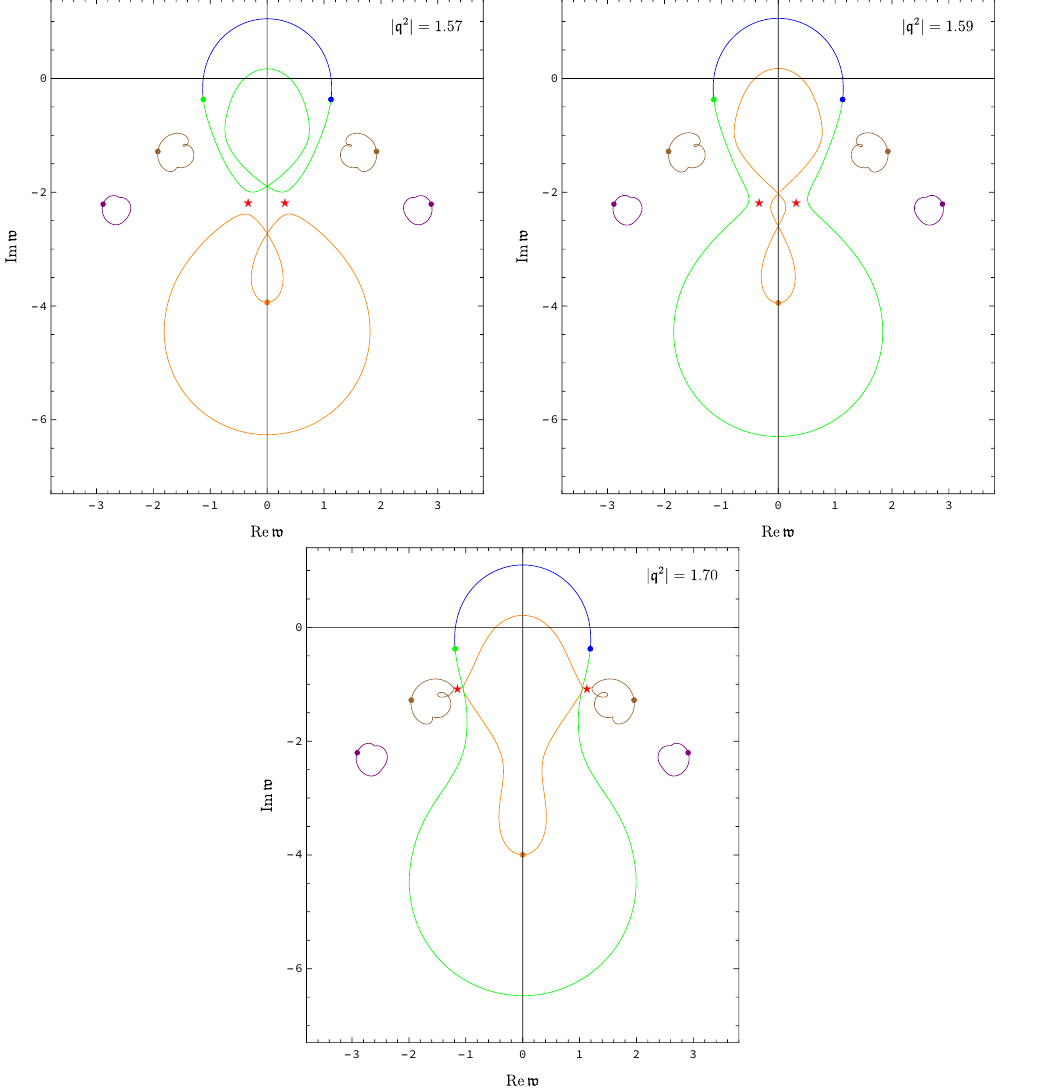
Figure 15 . Quasinormal spectrum in the sound channel of Gauss-Bonnet theory, computed non- perturbatively in λ , at λ = − 0 . 04 . The trajectories are plotted for complex values of the GB GB spatial momentum squared, q 2 = | q 2 | e iϕ , where phase ϕ is varied from 0 to 2 π . The positions of the quasinormal modes at ϕ = 0 are shown by dots. The positions of the critical points are shown by red